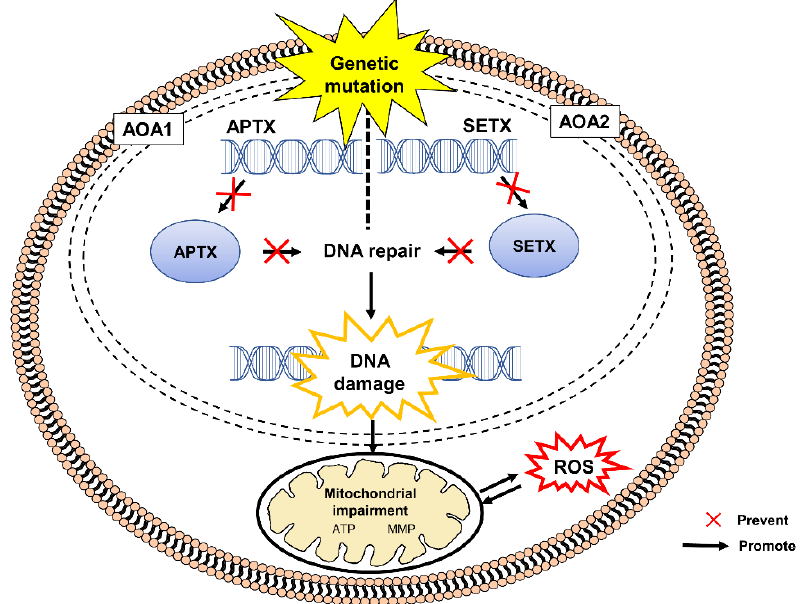
Figure 2. Mutations in the APTX and SETX genes in pathogenesis of AOA1 and AOA2, respectively. The defective genes result in the disruption of DNA repair mechanisms that are critical for maintaining the integrity of genomic DNA and subsequent accumulation of unregulated DNA damage. An absence or deficiency of APTX or SETX protein contributes to the impairment of mitochondria leading to excessive production of ROS. AOA, ataxia with oculomotor apraxia, APTX, aprataxin, ATP, adenosine triphosphate; SETX, senataxin, DNA, deoxyribonucleic acid, MMP, mitochondrial membrane potential; ROS, reactive oxygen species.